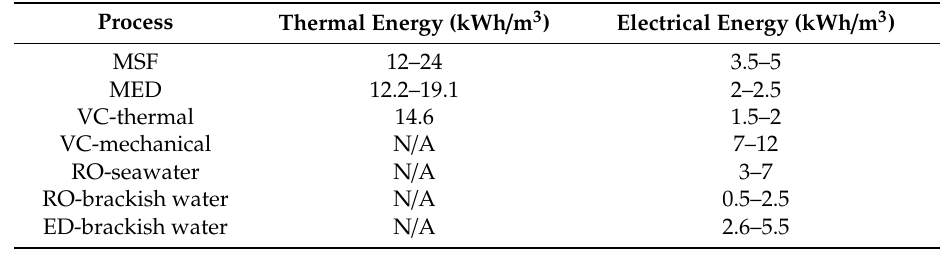
Figure 9. Breakdown of specific energy consumption in kW · h / m 3 (presented in log scale) of the PVD system when desalinating synthetic produced water (TDS = 10 g / L) at 85 ◦ C with cross-flow Reynolds number of 4800 and permeate vacuum of 0.85 bar. The blue solid bars and red hatch bars represent specific electrical and thermal energy consumption, respectively. Table 7. Energy consumption for various desalination technologies [80–82].